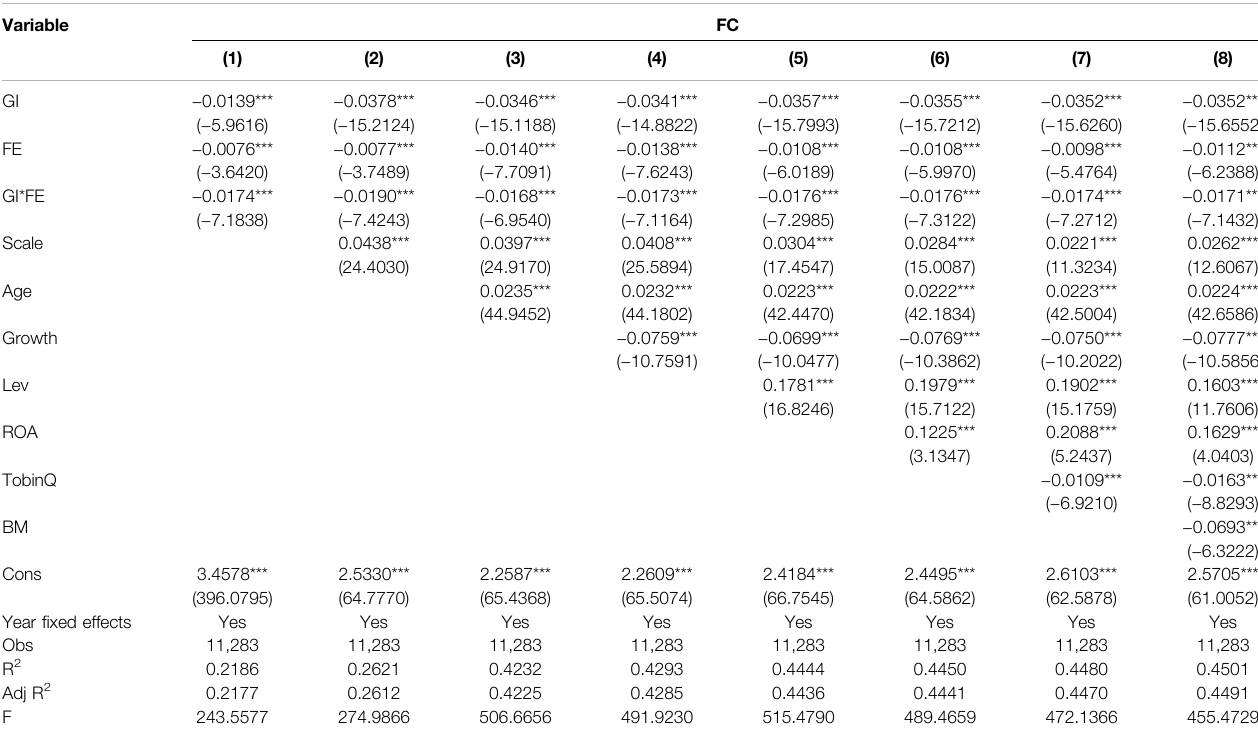
TABLE 7 | Regression results of M 2 .